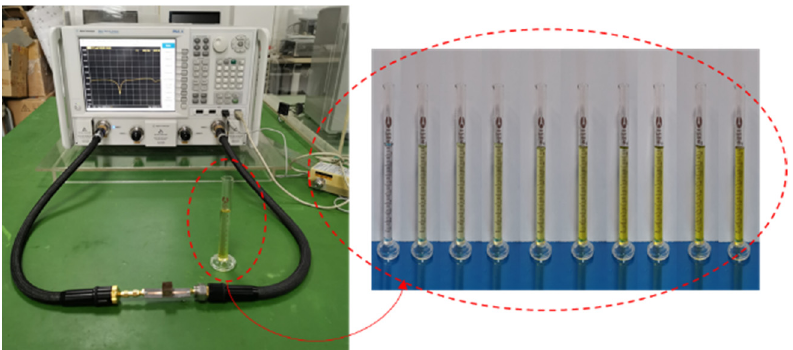
Figure 12. The measurement system for the fabricated sensor.